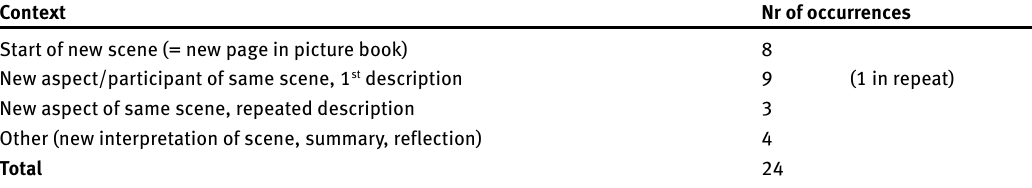
Table 4. Use of =mirndi ‘EGO+TU’ in one Frog Story narrative (IP;